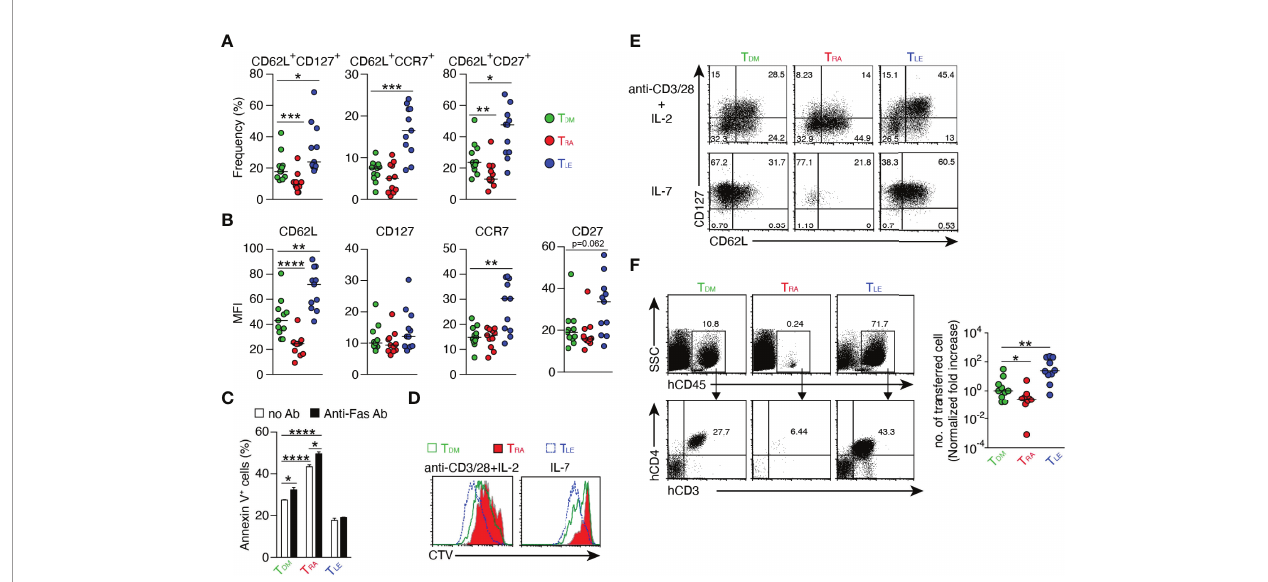
FIGURE 4 | Regulation of T cell differentiation by RAR signaling. Human CD4 + CD45RO + T cells were stimulated with anti-CD3/CD28 mAbs in the presence of DMSO, RA (1 m M), or LE540 (10 m M). Seven days later, the T cells were rested in IL-2-free medium overnight and then used for subsequent experiments. (A, B) Surface phenotypes of T DM , T RA , and T LE cells. Each symbol indicates the results (n = 11) obtained from six independent experiments. (C) Frequency of apoptotic cells for T DM , T RA , and T LE cells after 4 h of incubation with or without anti-Fas Ab (n = 3). (D, E) T DM , T RA , and T LE cells were labeled with CTV and stimulated with the indicated agents. (D) Analysis of cell proliferation using CTV dilution after 4 days of stimulation. (E) The T cells were harvested after 5 days of the stimulation, rested in a cytokine-free medium overnight, and analyzed for their surface phenotypes. Representative data from three independent experiments are shown (C-E) . (F) T DM , T RA , and T LE cells were co-transferred with CD3 + T cell-depleted autologous PBMCs into NOG mice. Four weeks later, a fl ow cytometric analysis was performed to evaluate transferred cells in the spleen. Representative dot plots (Left) and normalized fold increases in the cell number (Right) are shown. The normalized fold increase was calculated by dividing each value by a median value of the corresponding control (i.e., T DM ) group. Data from three independent experiments are shown. Each symbol indicates results from a single mouse (n = 10). Data were analyzed by Mann – Whitney tests (A, F) or unpaired t-tests (C) . Error bars show s.e.m. *p < 0.05; **p < 0.01; ***p < 0.001;